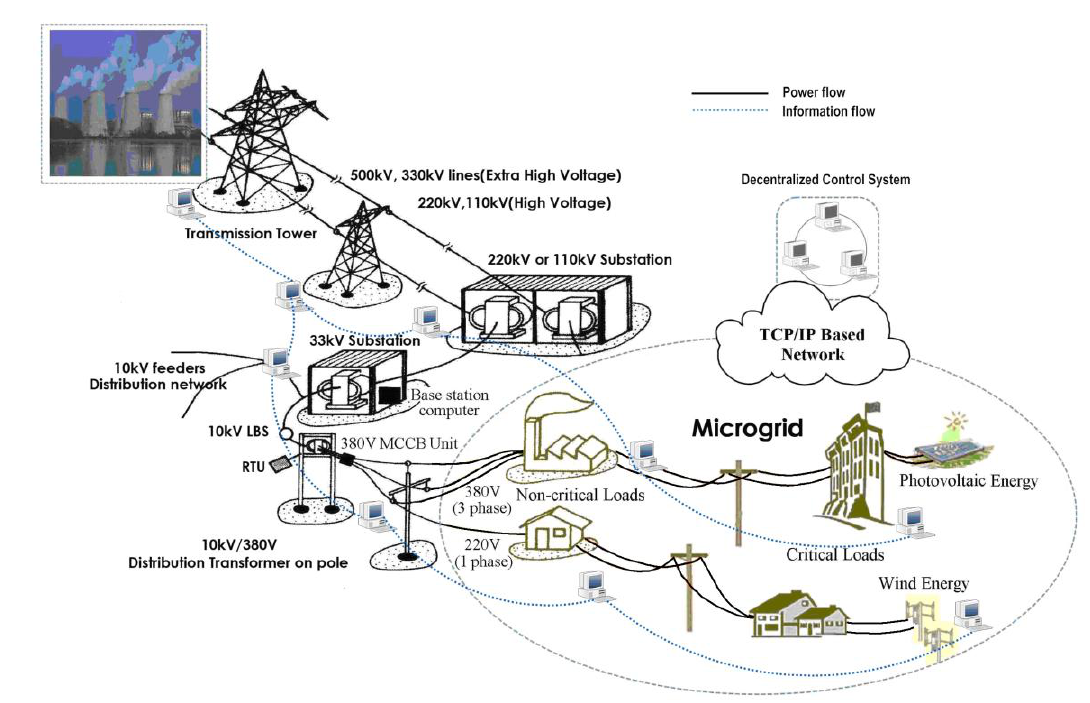
Figure 1. An overall framework of a modern electric